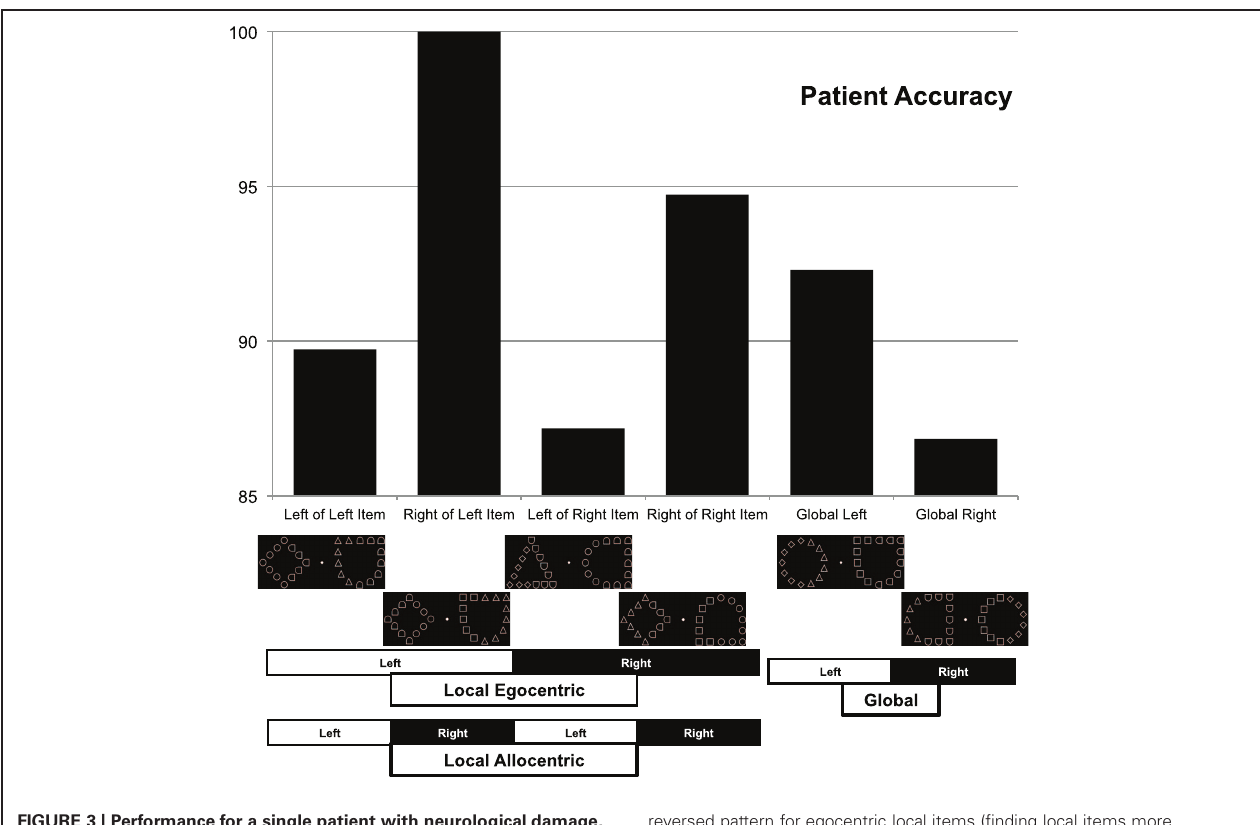
FIGURE 3 | Performance for a single patient with neurological damage, using the same layout as Figure 2. Note that this individual exhibits the same pattern of allocentric and global performance as healthy adults, yet a